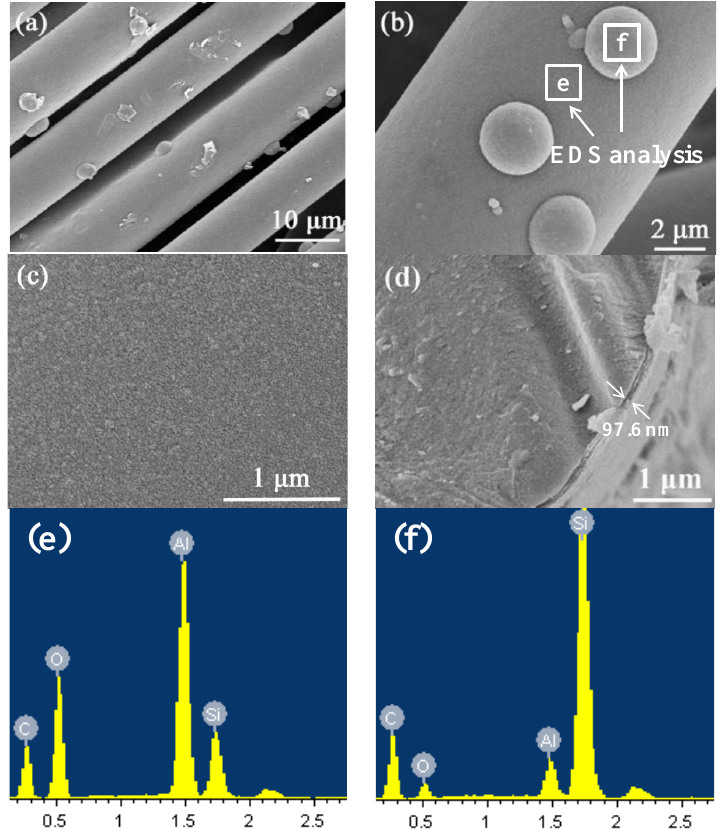
Figure 8. Surface morphology and EDS analysis of the coatings deposited for 2 h after ultrasonic treatment: ( a ) overview image, ( b ) detailed image with marked areas for the EDS measurement, ( c ) detailed image for smooth area of the fiber surface, ( d ) detailed image for the fracture surface, ( e ) EDS measurement of smooth area and ( f ) EDS measurement of bulges.